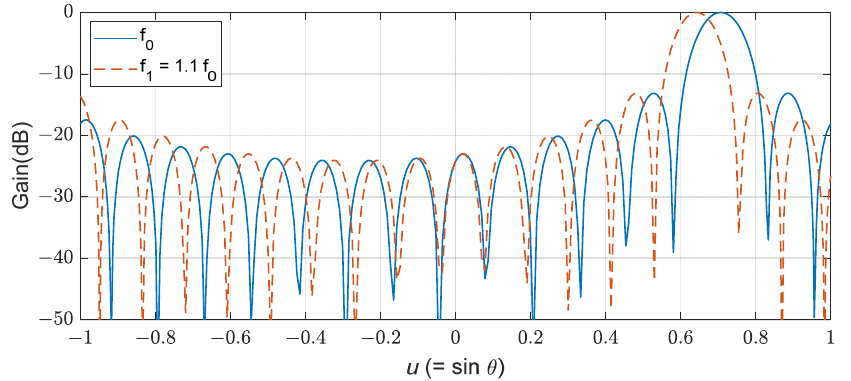
Figure 5. Comparison of the beampatterns of two frequencies.